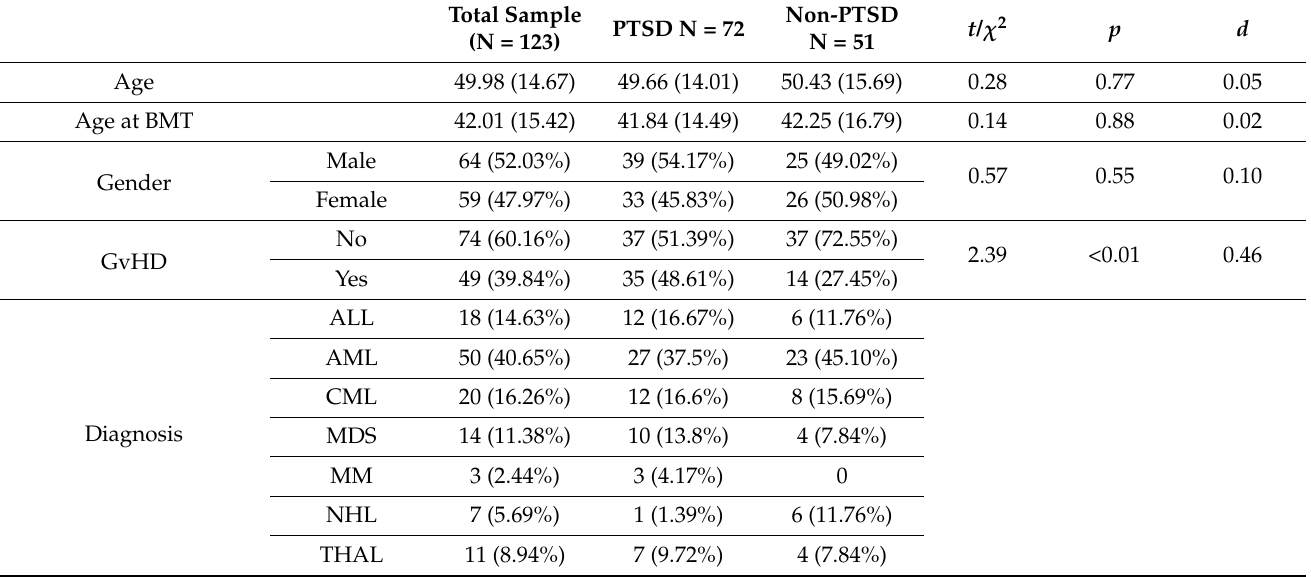
Table 1. Socio-demographic and clinical characteristics between groups: with and without PTSD